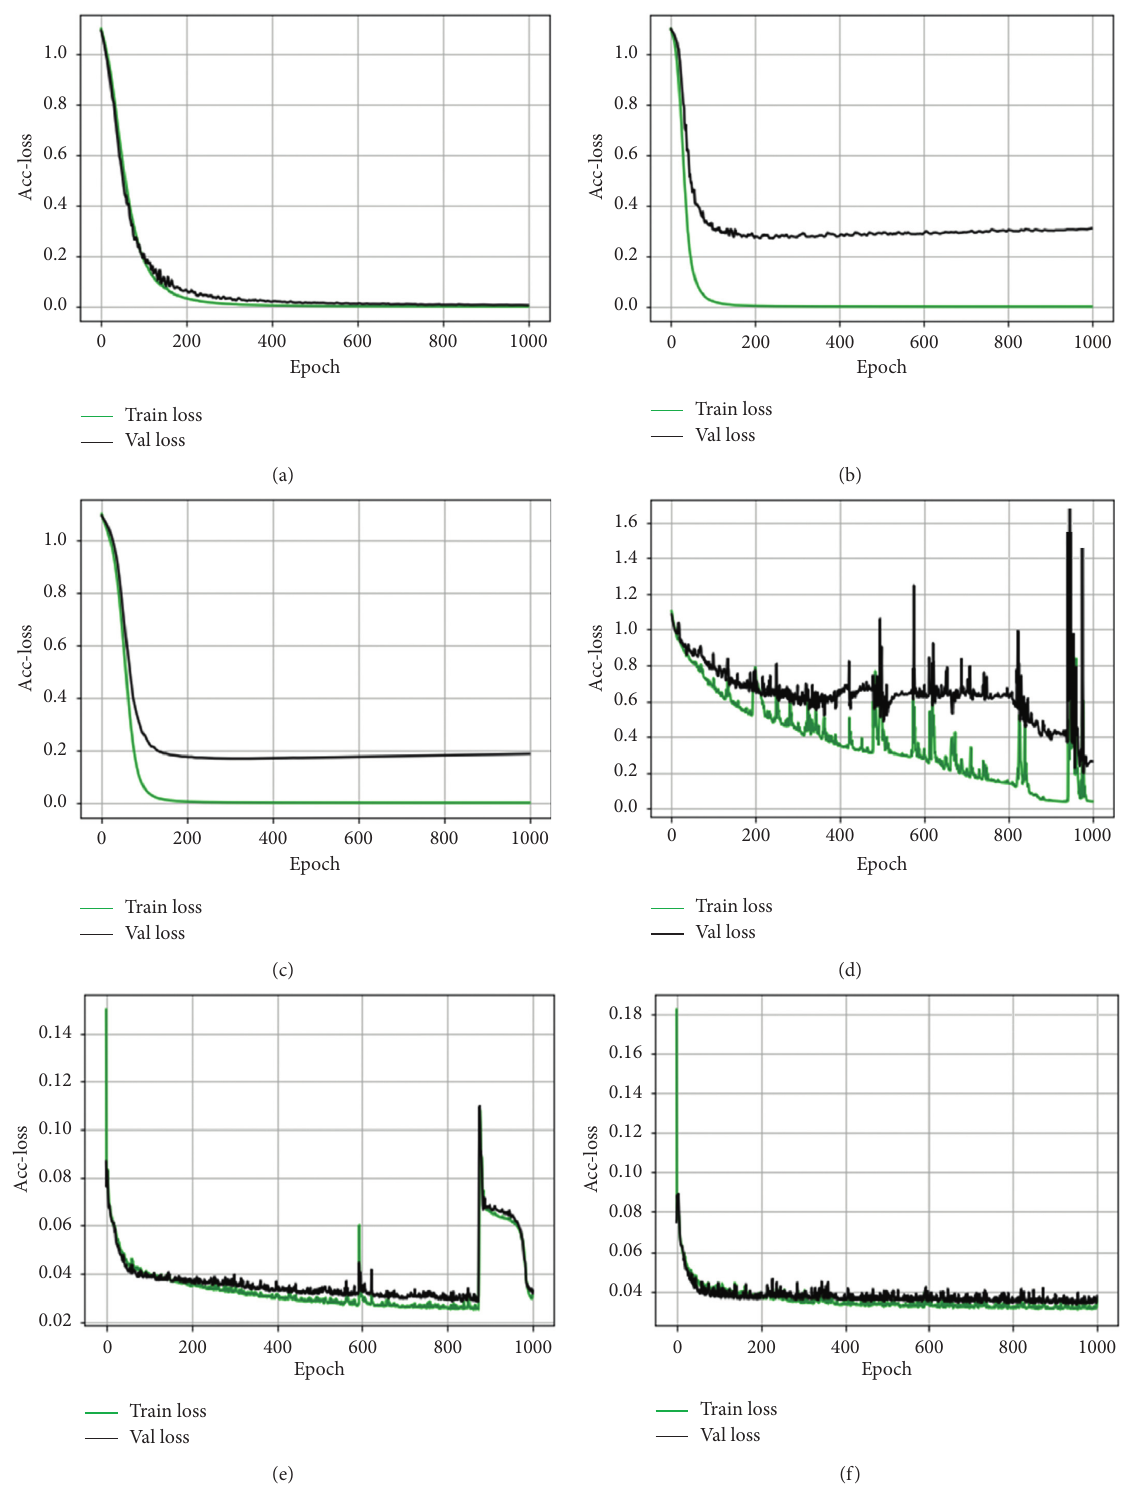
Figure 3: The changes in loss values of various models. (a) 1D-CNN. (b) CNN. (c) DNN. (d) RNN. (e) CapsuleNet. (f)